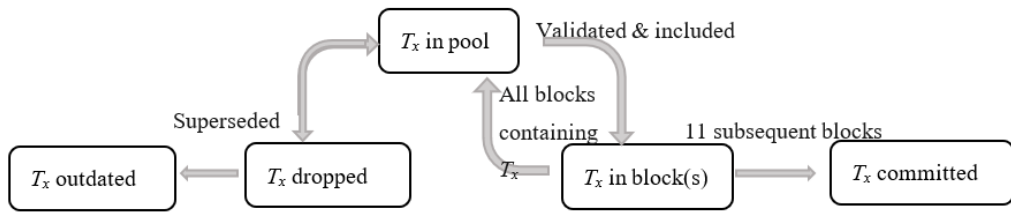
Figure 3. Transaction inclusion in Ethereum (adopted from Reference [46]).